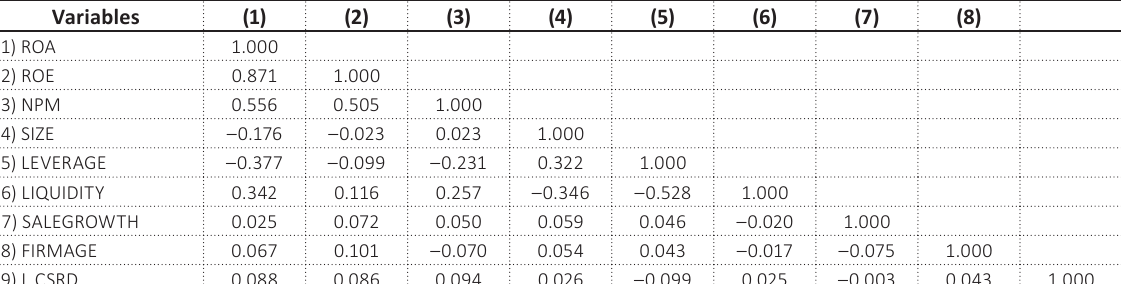
Table 6. Correlation